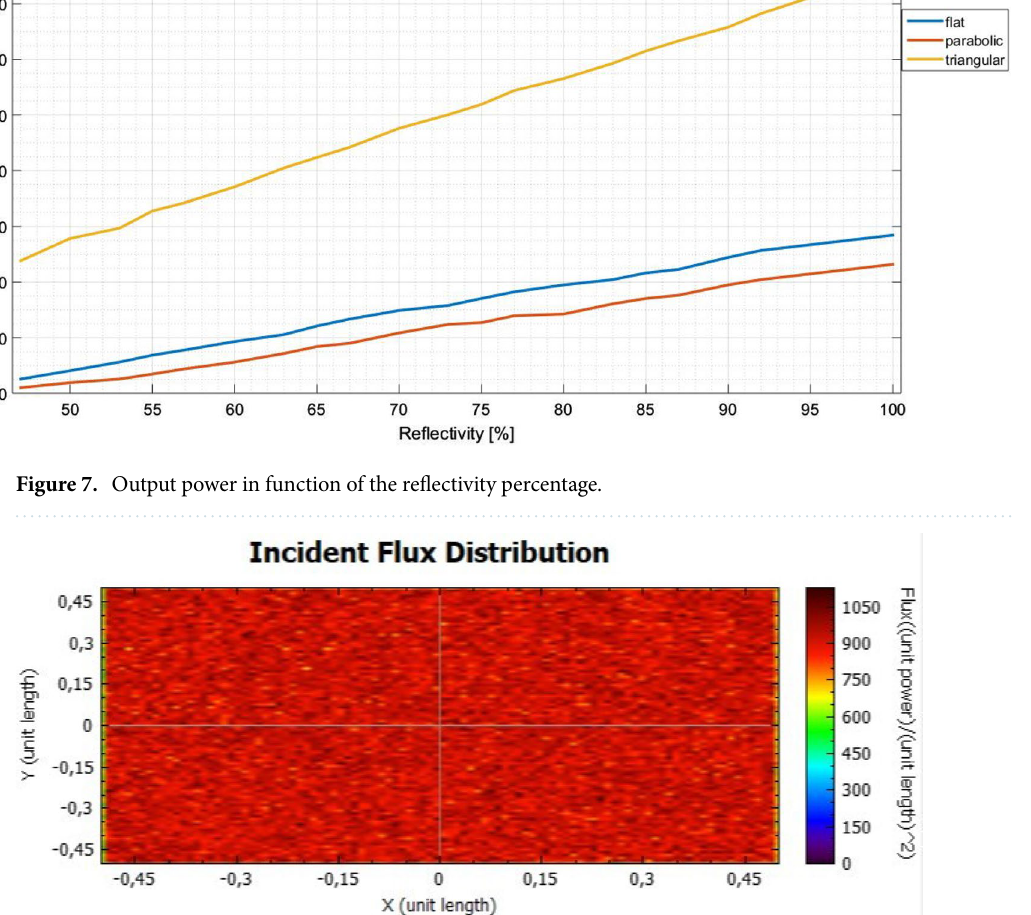
Figure 8. Distribution of incident flux at the receiver from the flat concentrator characterised by a reflectivity of